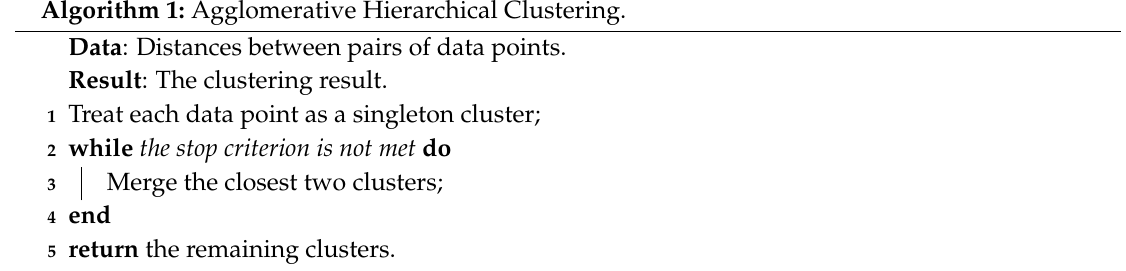
Algorithm 1: Agglomerative Hierarchical Clustering.